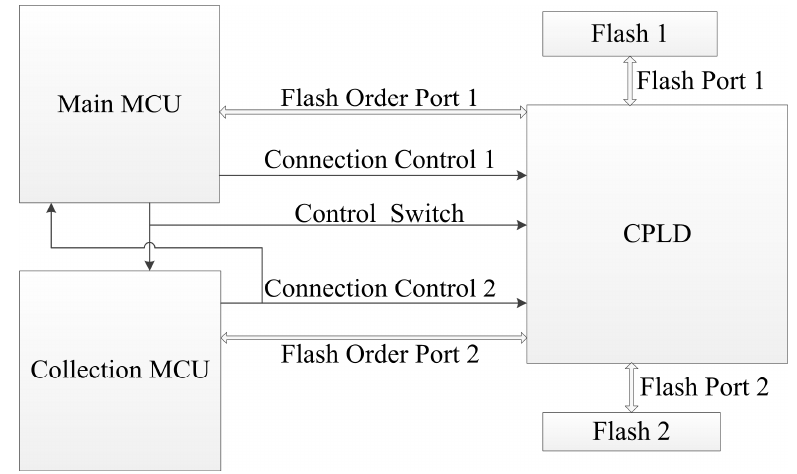
Figure 3. Detailed port connections for flashes.